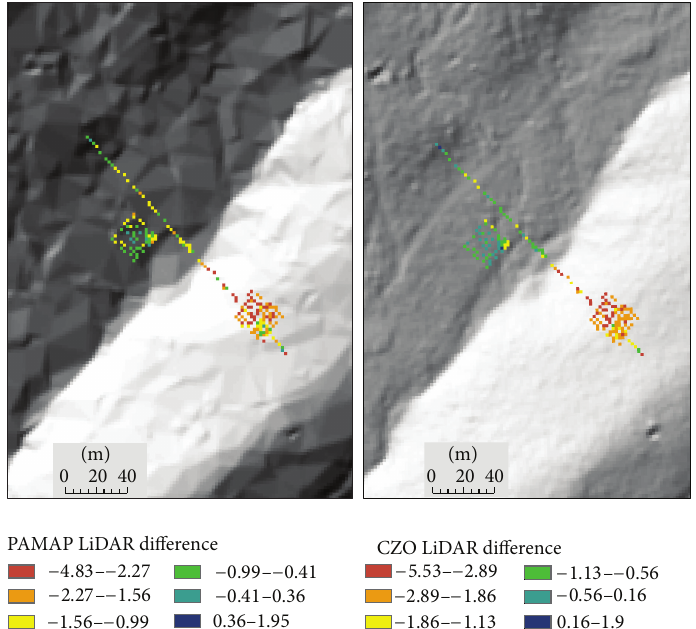
Figure6:Close-upviewoftwoplotsandtransect.ValuesrepresentthedifferencebetweensurveyedelevationsandLiDAR-derivedelevations. Images are overlain over shaded relief maps of corresponding DEMs. Values in the key are in feet to match the original units of the DEMs.